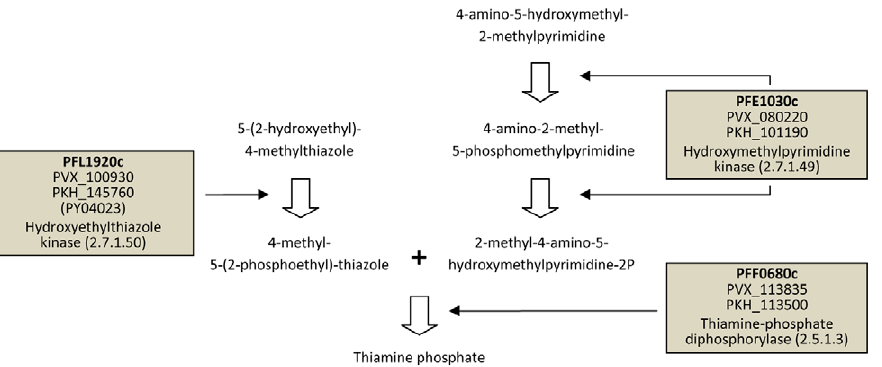
Figure 2. Rodent malaria parasites likely deficient in denovo synthesis of thiamine (vitamin B1). The diagram illustrates catalytic steps of the thiamine biosynthesis pathway in P. falciparum , with 4-amino-5-hydroxymethyl-2-methylpyrimidine and 5-(2-hydroxyethyl)-4-methylthiazole as start products and thiamine phosphate as the end product. The three enzymes predicted to be absent in rodent malaria parasites catalyze subsequent reactions in this pathway, suggesting that rodent malaria parasites are deficient in de novo synthesis of vitamin B1. Gene identifiers correspond to P. falciparum genes (bold) and their P. vivax and P. knowlesi orthologs (below). PFL1920c has a predicted but severely truncated ortholog in P. yoelii (PY04023). Figure based on pathway shown in the Malaria Parasite Metabolic Pathways (MPMP) database [26].